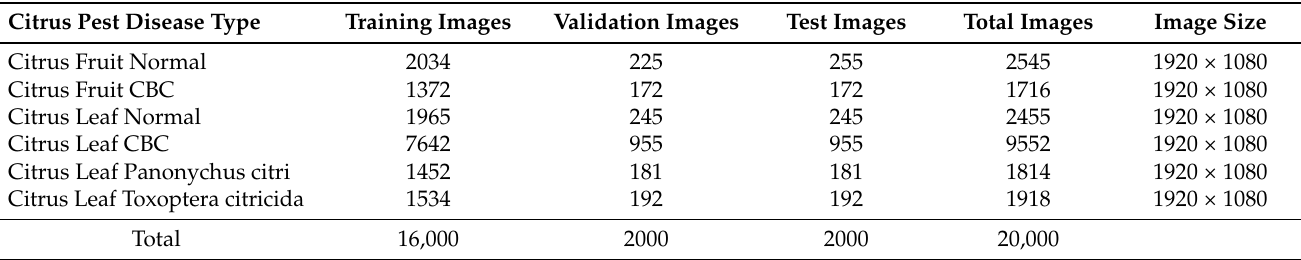
Figure 3. Citrus unshiu pest disease image sample: ( a ) Citrus fruit normal. ( b ) citrus fruit CBC. ( c ) citrus leaf normal. ( d ) citrus leaf CBC. ( e ) citrus leaf Panonychus citri. ( f ) citrus leaf Toxoptera citricida. Table 2. Summary of the dataset